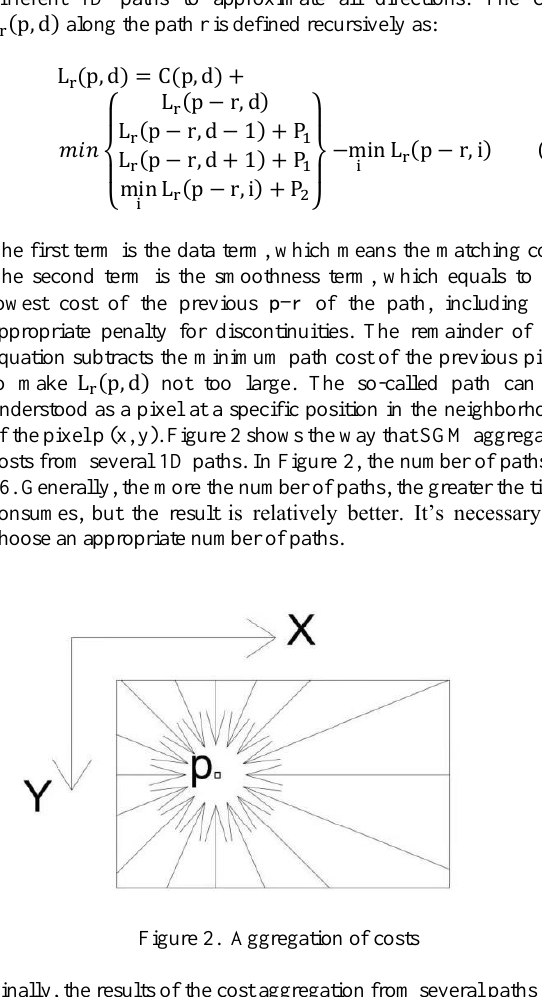
Figure 3. Height search range for dense